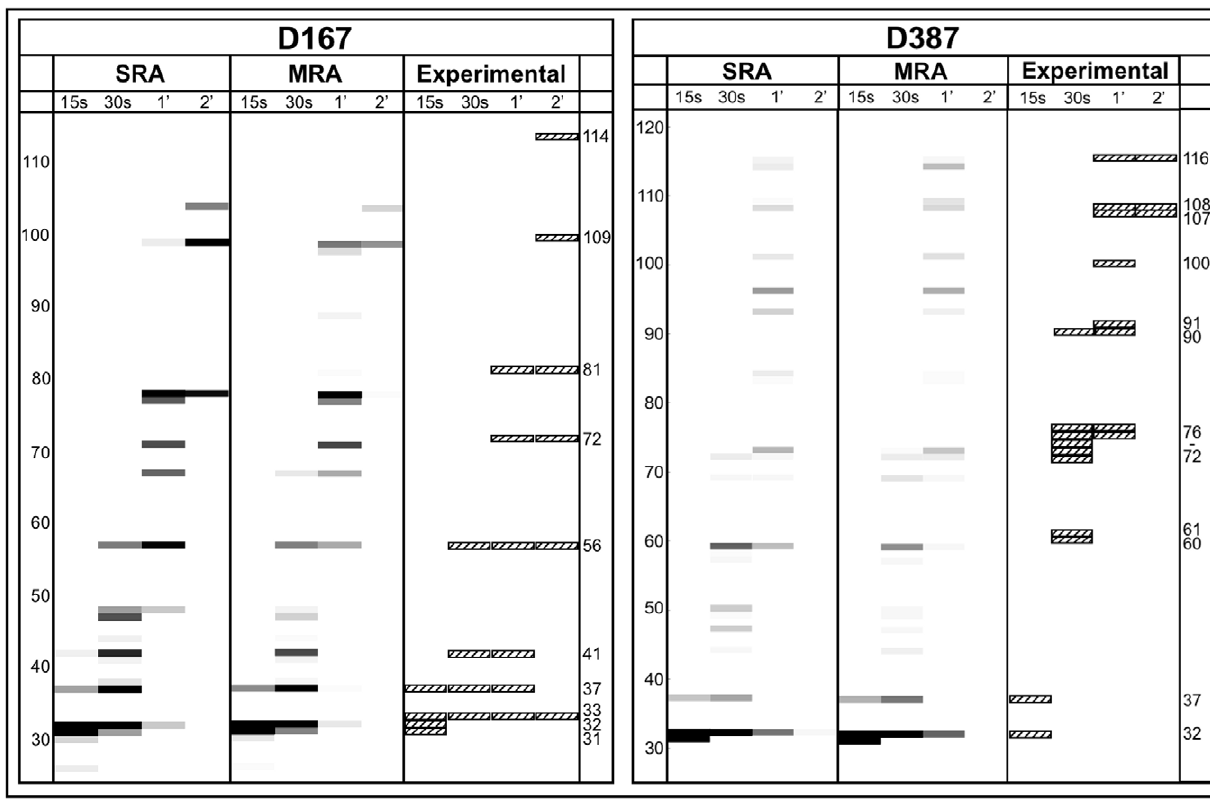
Figure 11. Comparison among the simulated transcription gels in different times: a) Template D167. b) Template D387. Each column represents the reaction time for that simulation. The intensity of the bands is proportional to the amount of produced transcripts of that length in the allowed time. The experimental results shown here are graphical reproductions of the gels presented in the experimental work of Bai and Wang [23]. The experimentally observed bands are indicated with their respective transcript size. Some false positives present in the SRA appear less intense in the MRA . For the single-round and the multi-round elongation: some bands appear earlier in MRA than in SRA and the predicted intensities are different for most bands.